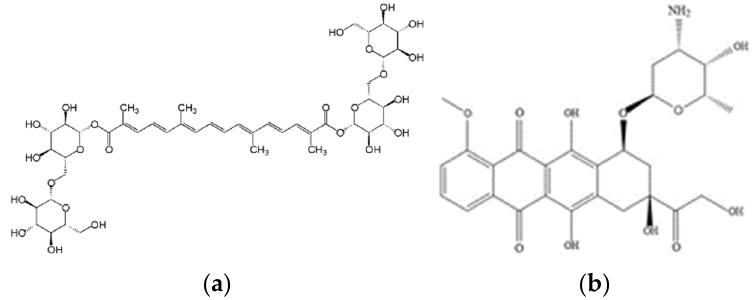
Figure 1. Scheme of the molecular structures of ( a ) Crocin and ( b ) Doxorubicin.